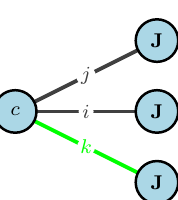
Figure 4 . Fork diagram. J is paired through G with c , and the k index becomes an identity pairing similar to figure